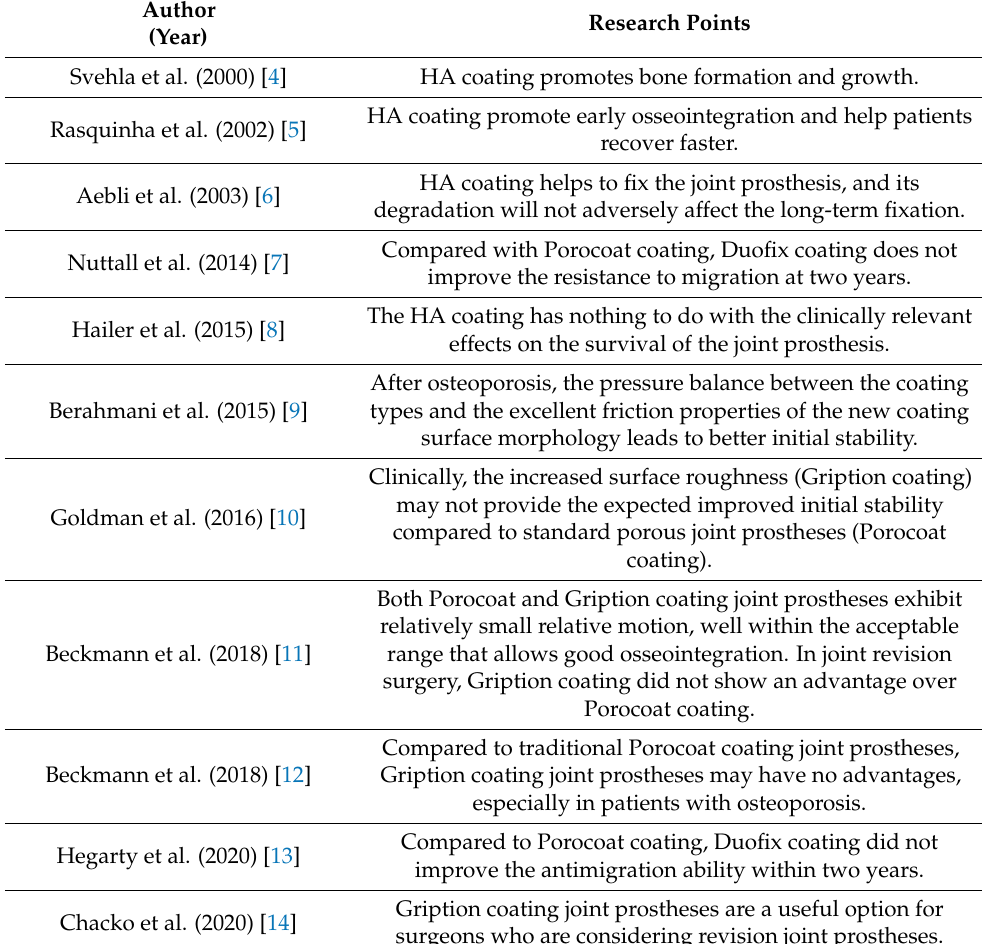
Table 1. The characteristics of included